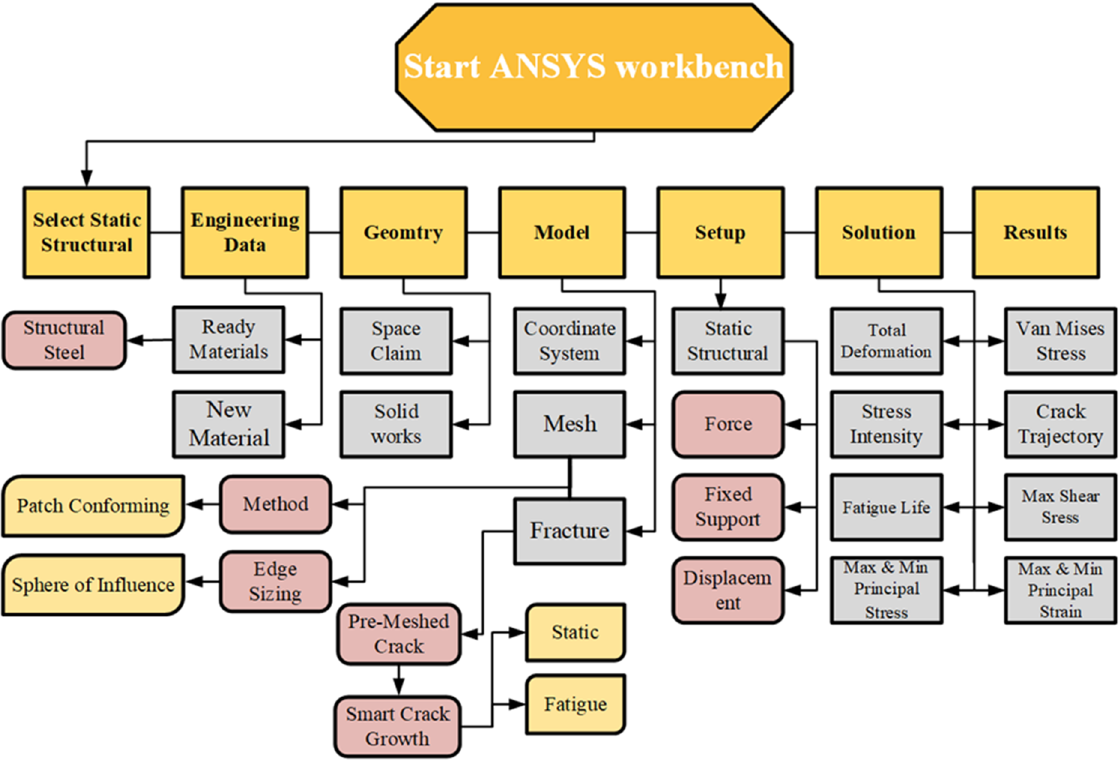
Figure 1. Flowchart for the ANSYS SMART procedures.